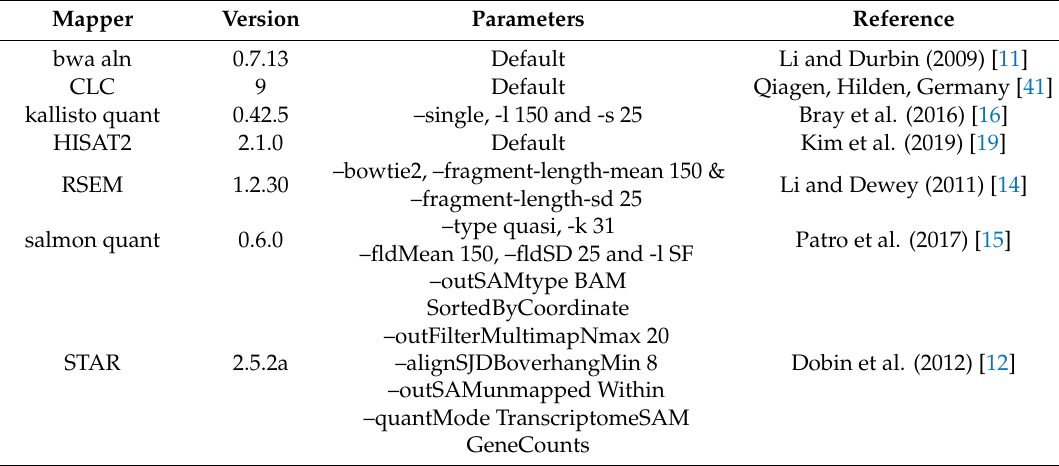
Table 6. Overview of the seven mappers used in this